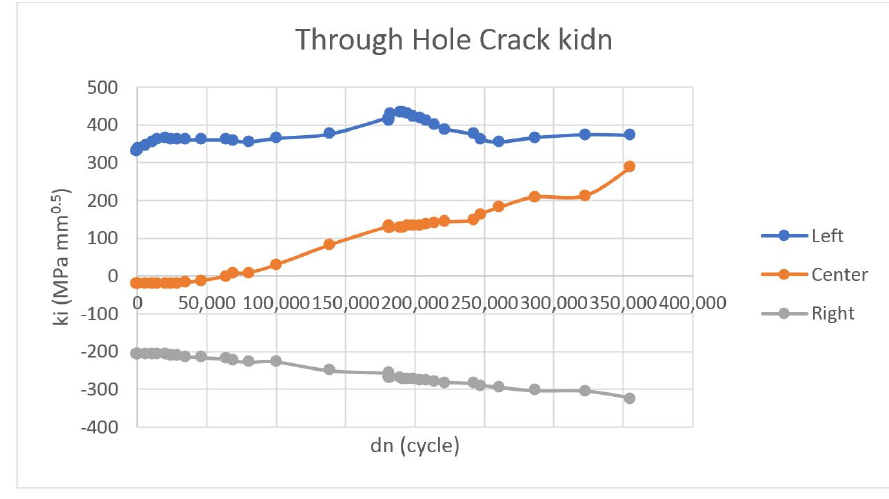
Figure 15. Cycle vs. K I for through hole crack.